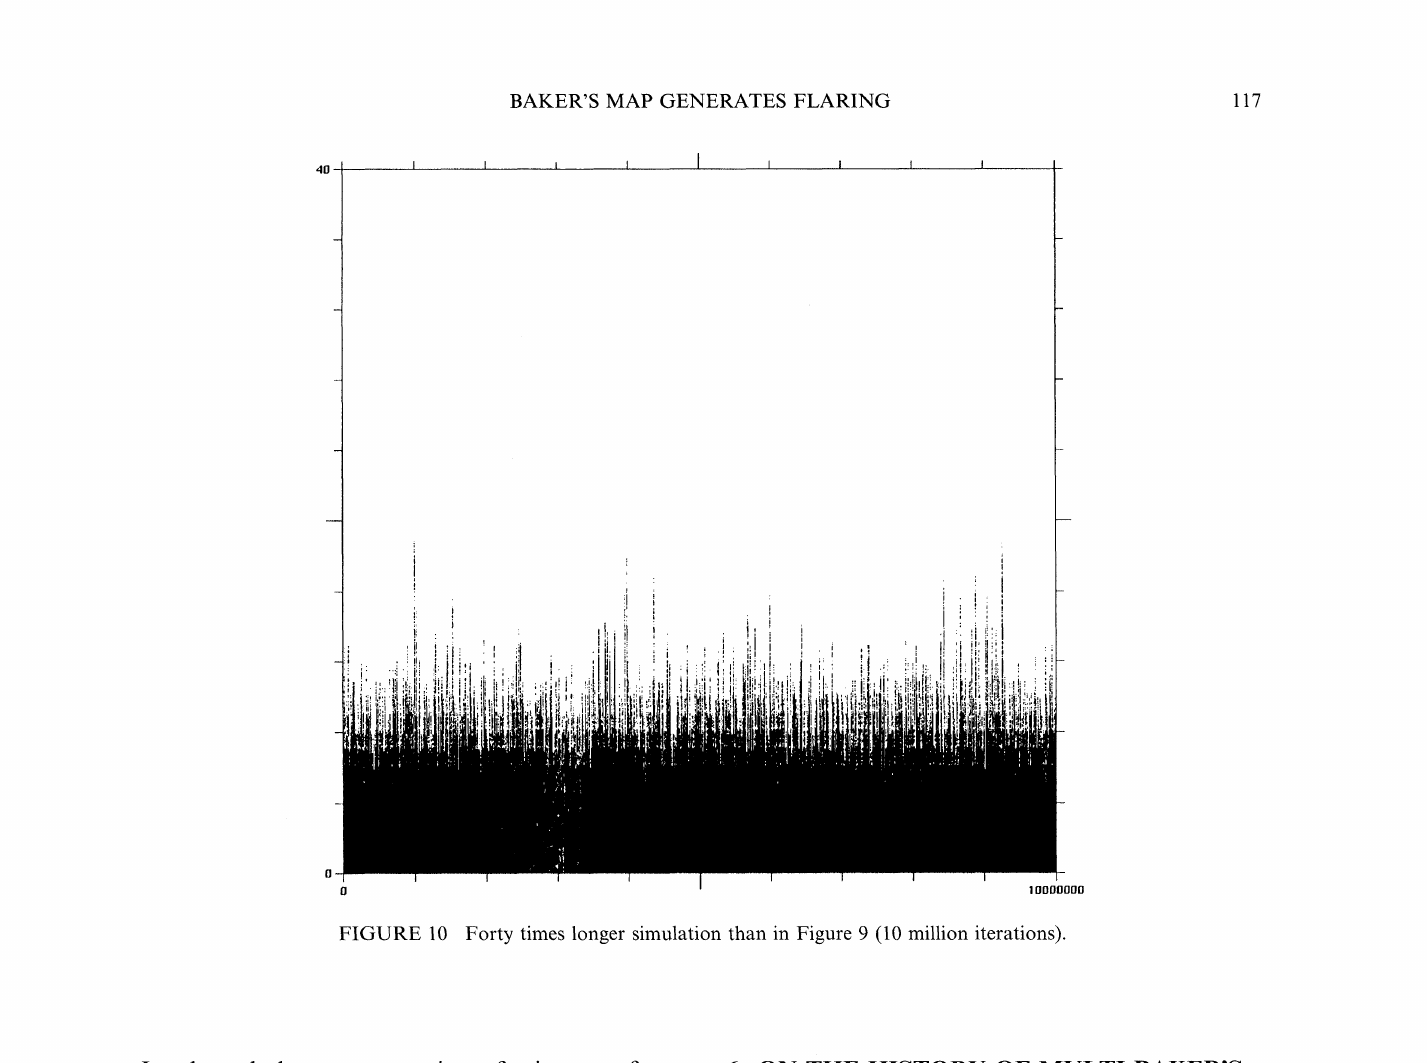
FIGURE 10 Forty times longer simulation than in Figure 9 (10 million